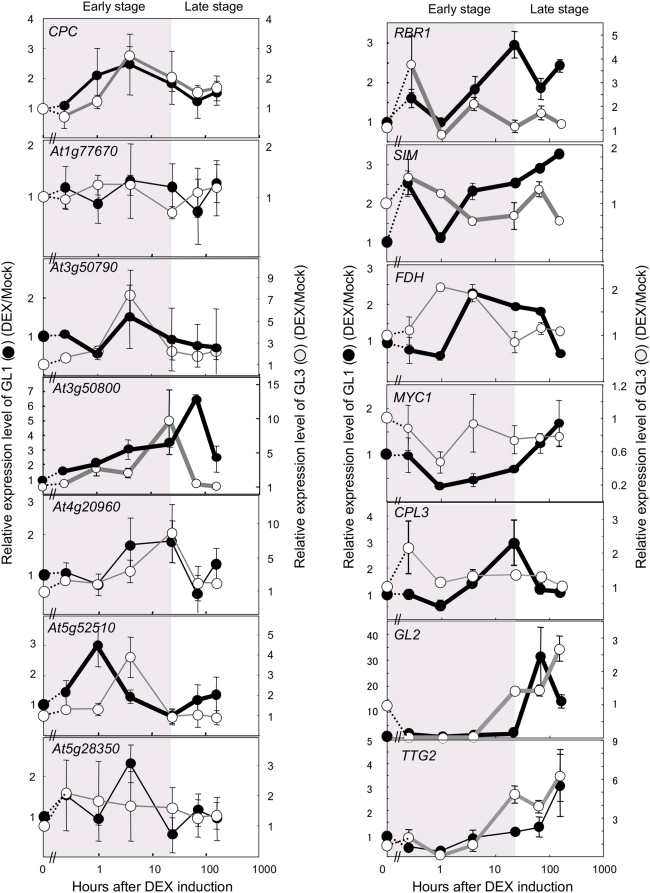
Expression of a select set of GL3 and GL1 direct targets after DEX induction of GL3-GR or GL1-GR.qRT-PCR experiments performed on mRNA obtained from gl1 pGL1::GL1-GR or gl3 egl3 pGL3::GL3-GR seedlings DEX- or Mock-treated for various times (15 min, 1 hr, 4 hrs, 24 hrs, 3 days and 7 days). It should be noticed that the y-axis is drawn in linear-scale whereas the x-axis is in log-scale. Black circles correspond to expression in gl1 pGL1::GL1-GR plants and white circles to expression in gl3 egl3 pGL3::GL3-GR plants. For each time-point, the ratio between the DEX and Mock treatment was calculated. For clarity purposes, the pre-induction condition (time = 0) is shown, and corresponds to no induction (ratio = 1). Induction times, corresponding to early stages of trichome development (0–24 hrs), are indicated shaded gray. For each time point, biological triplicates were collected and the error bar indicates the standard error. Thick lines correspond to gene expression profiles for which ANOVA statistical analyses suggested a significant difference (P<0.05). Thin lines indicate cases for which statistical significance could not be supported to biological variation between the triplicates.